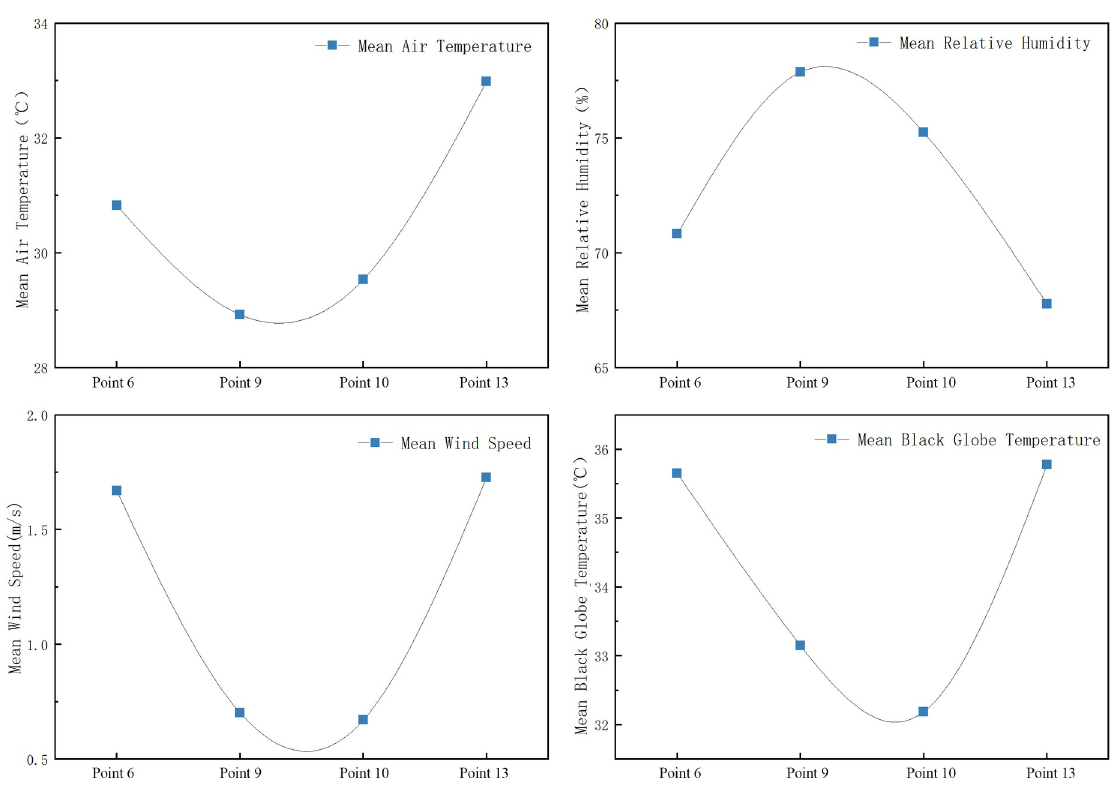
Fig 16. Mean variation of meteorological parameters at each measurement point of green space.